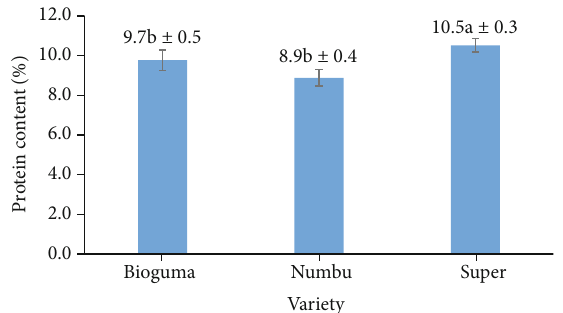
Figure 13: Protein content of three varieties of polished sorghum grains.